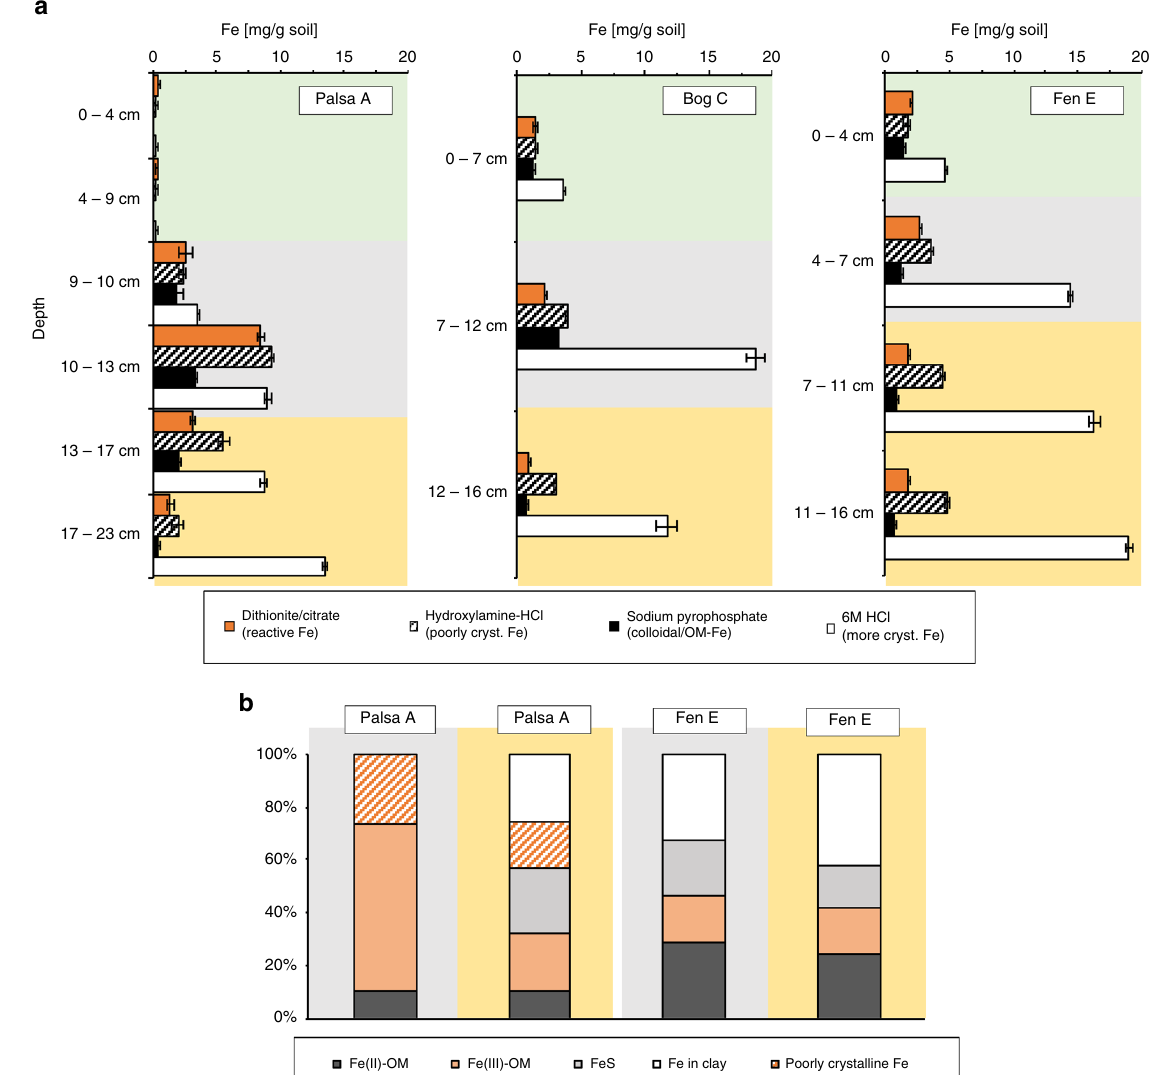
Fig. 3 Reactive Fe along the permafrost thaw gradient. Fe speciation was determined along the thaw gradient by selective extractions ( a ) and extended X-ray absorption fi ne structure (EXAFS) ( b ). The reactive iron mineral fraction (dithionite citrate extractable) [mg iron (Fe) per g soil] was quanti fi ed in the different layers, control corrected by a sodium chloride bicarbonate extraction with the same ionic strength and pH (Supplementary Table 1), and compared to the poorly crystalline Fe (hydroxylamine-hydrochloric acid (HCl) extractable Fe), the more crystalline Fe (6 M HCl extractable Fe, referred to mg Fe(tot) per g soil in the text) and to the colloidal and/or organic matter (OM)-chelated Fe (sodium pyrophosphate extractable Fe). Please note the differences in the scale of the y -axis due to variable thickness of each soil layer along the thaw gradient. The green background marks the organic horizon, gray the transition zone, and yellow the mineral horizon. Error bars of all extractions represent duplicate extractions of each layer per thaw stage, except for the dithionite citrate extractable iron which represents a combined standard deviation of sodium chloride bicarbonate extractable iron and dithionite/citrate extractable iron (not control corrected). EXAFS results of the transition zone and the mineral horizon of the two-end members palsa and fen show loss of the poorly crystalline Fe (reference probe: 2-line ferrihydrite), the decrease in OM-chelated Fe (reference probes: Fe(II)-citrate and Fe(III)-citrate), the increase of Fe in clays (reference probes: natural nontronite and ferrosmectite), and Fe sulfur species (reference probe: mackinawite) with depth and along the thaw gradient. Absolute values are reported in Supplementary Table